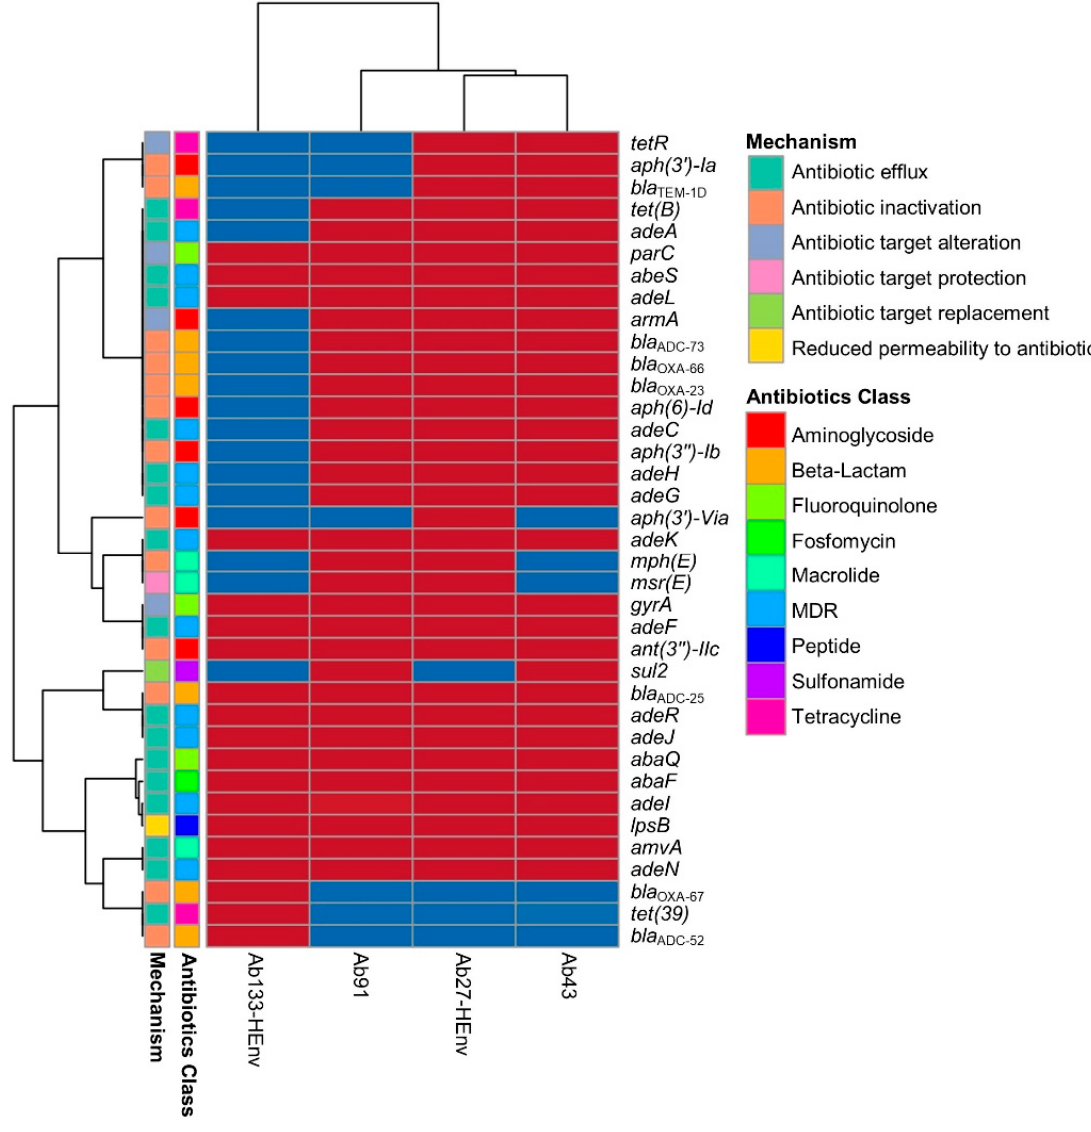
Figure 3. Acquired and intrinsic resistance genes retrieved from the Acinetobacter baumannii genomes of the isolates recovered from the hospital environment and clinical samples. MDR, multidrug resistance. The blue box indicates the respective gene was not detected.